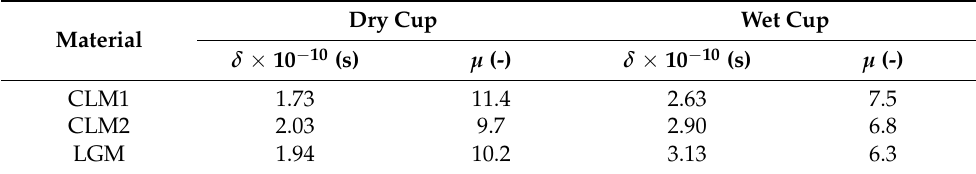
Table 7. The water vapor transport parameters of the hardened